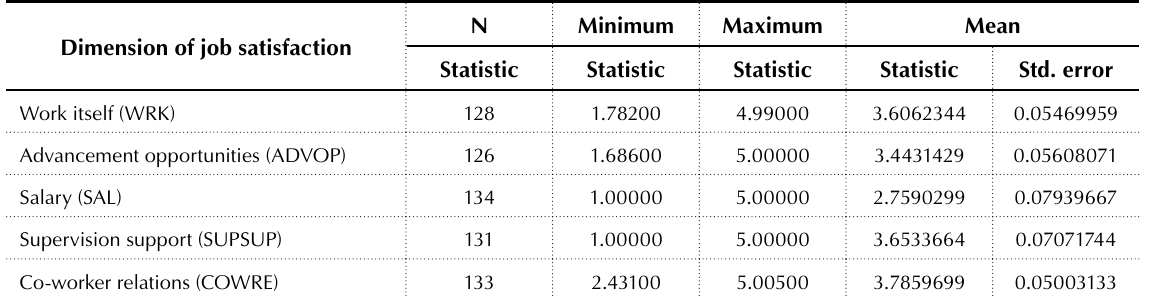
Table 2. Mean values of job satisfaction Dimension of job satisfaction